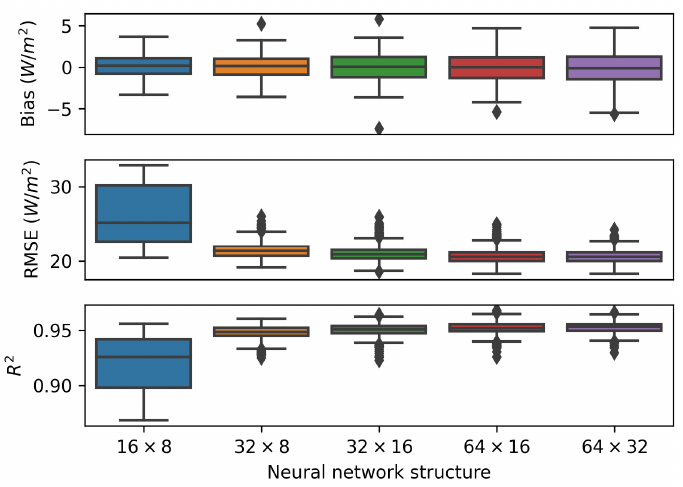
Figure 4. Performances of different neural network (NN) structures for surface downward longwave radiation (SDLR) estimation. The metrics are bias, root mean square error (RMSE), and R 2 from top to bottom. Each NN structure was trained 10 times. The “16 × 8” indicates two hidden layers in which the first layer has 16 neurons, and the second layer has 8 neurons. The 32 × 16 structure showed the best performance.